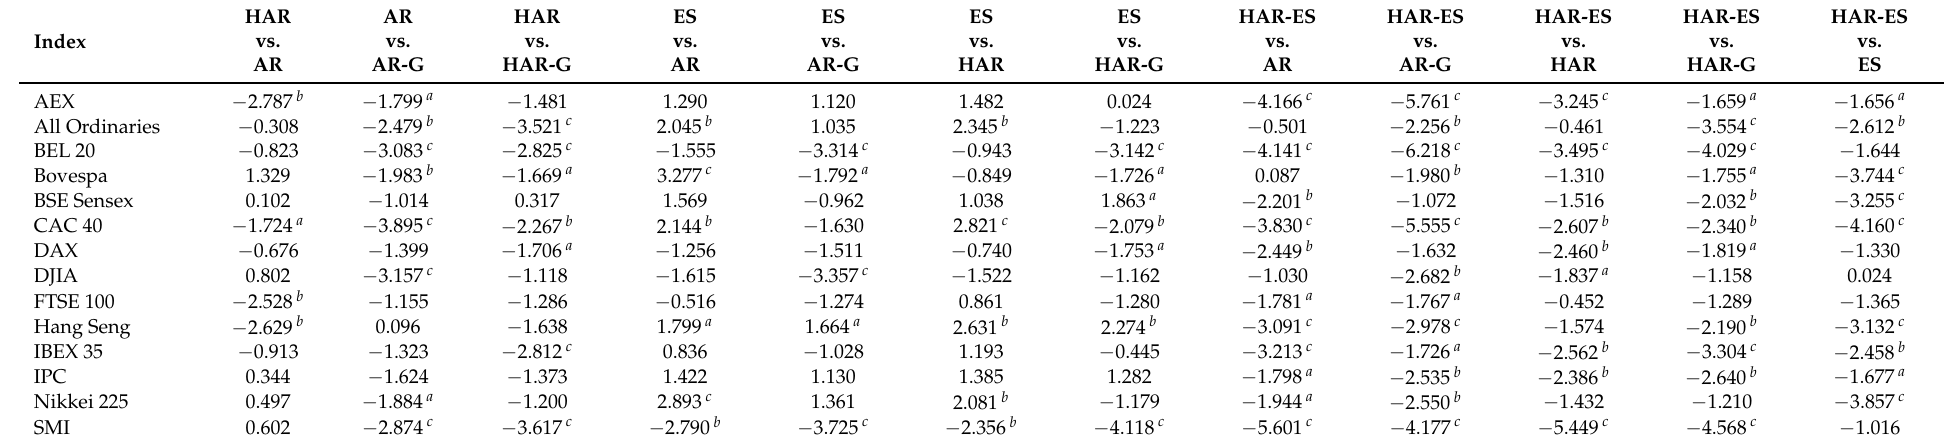
Table 7. Diebold–Mariano test based on the QLIKE losses.